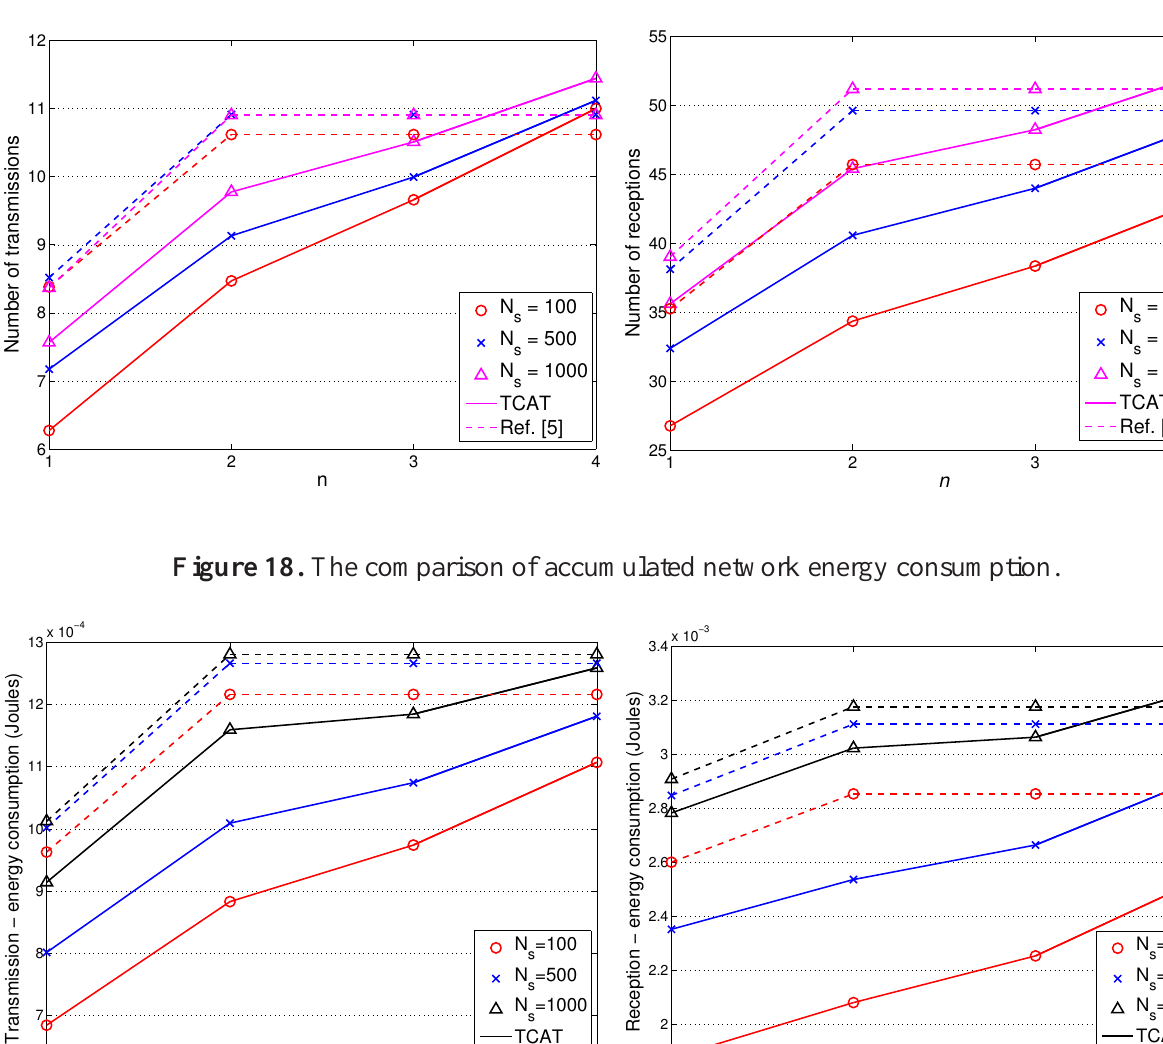
Figure 17. The number of transmission/reception: the communication cost.